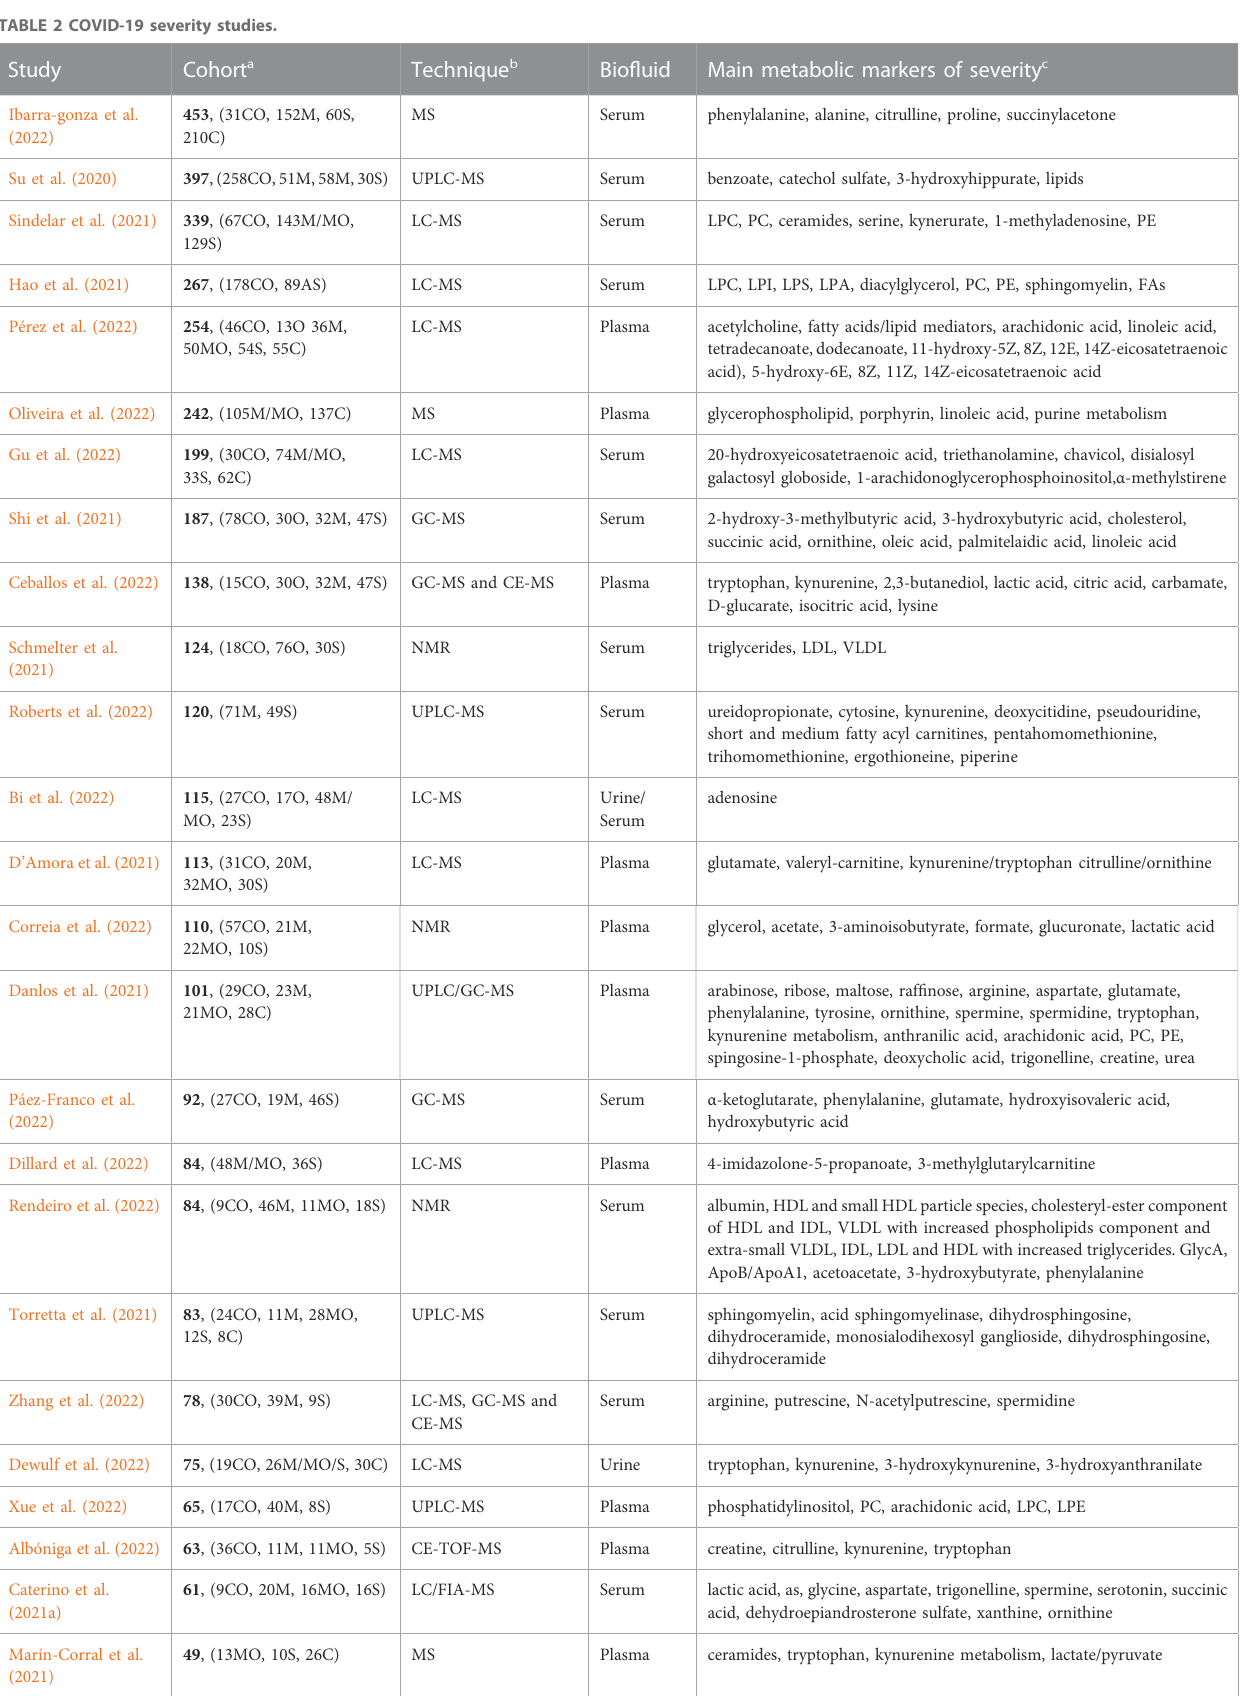
TABLE 2 COVID-19 severity